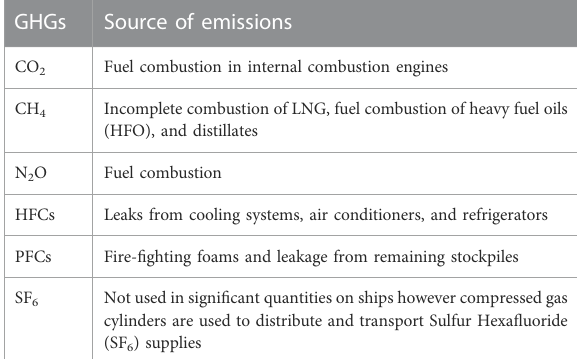
TABLE 1 Data retrieved from Third IMO GHG study 2015 and